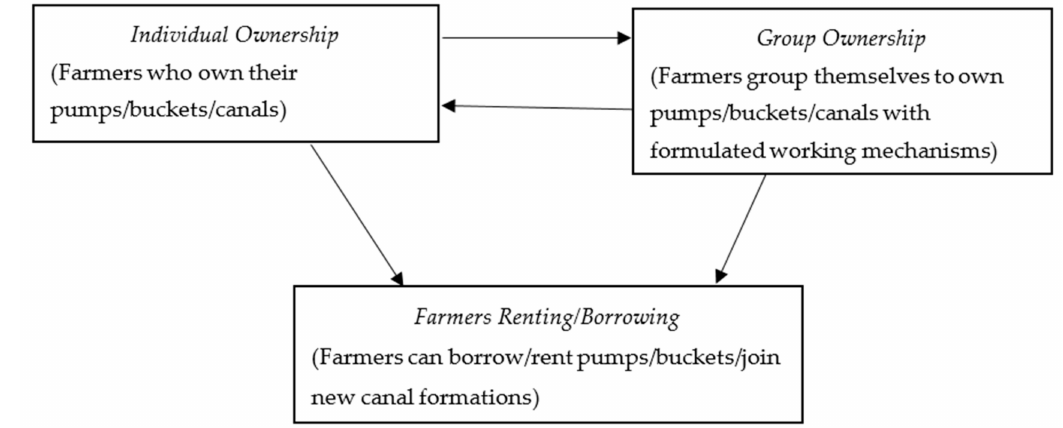
Figure 1. Farmer-led irrigation